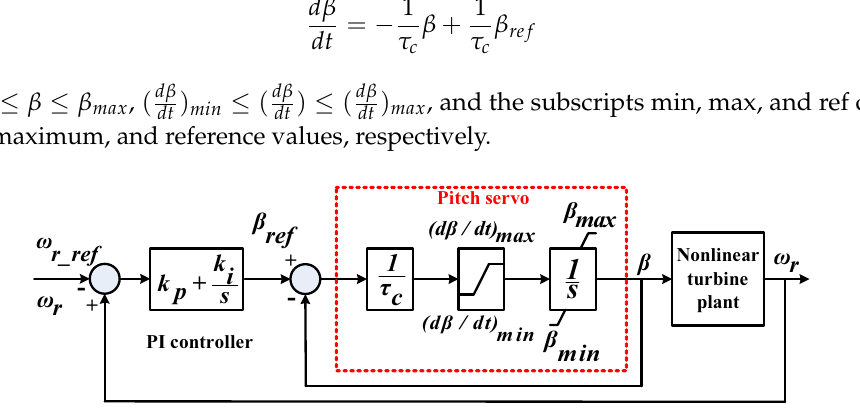
Figure 2. Block diagram of a typical pitch control system.